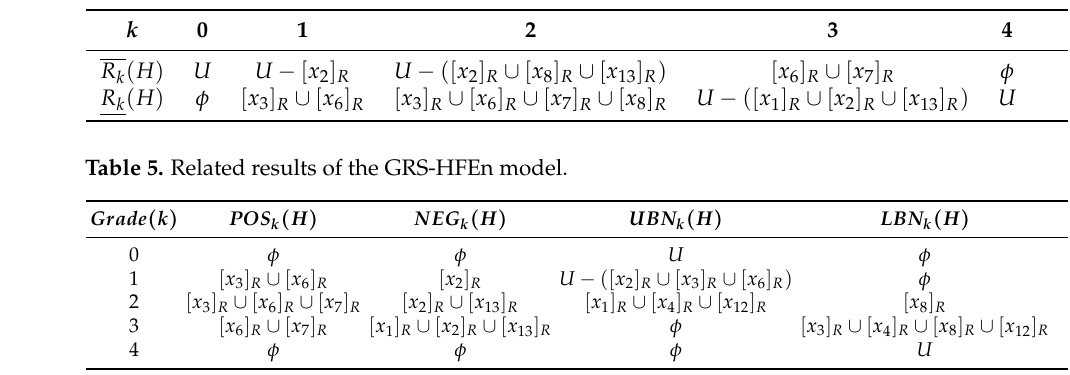
Table 4. The upper and lower approximations under the different values of k in GRS-HFEn model.